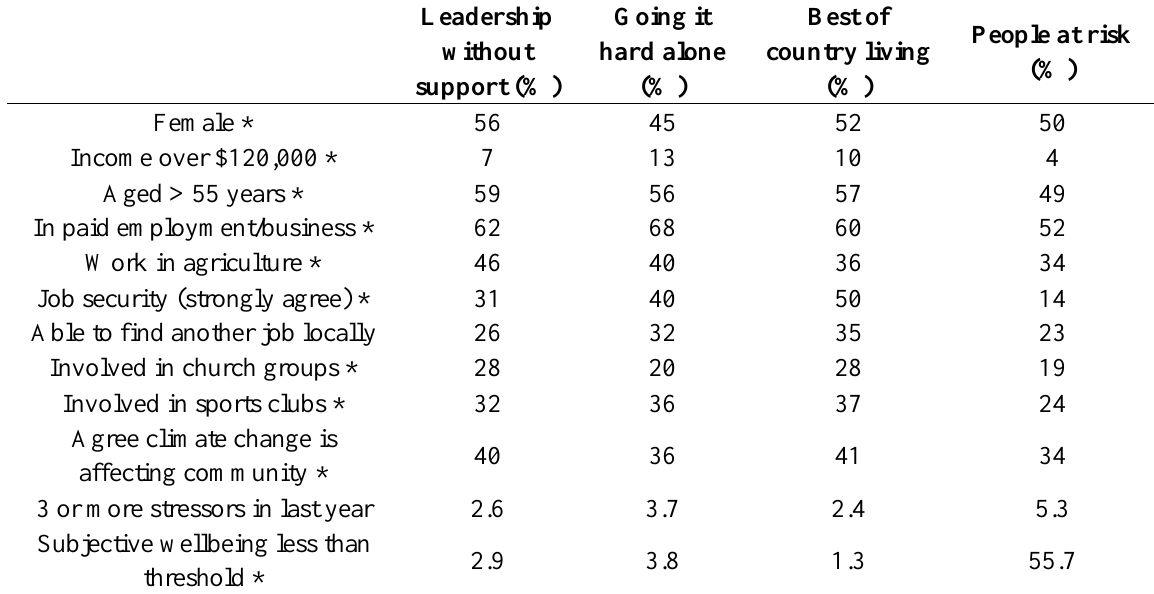
Table 8. Key descriptive statistics describing segment